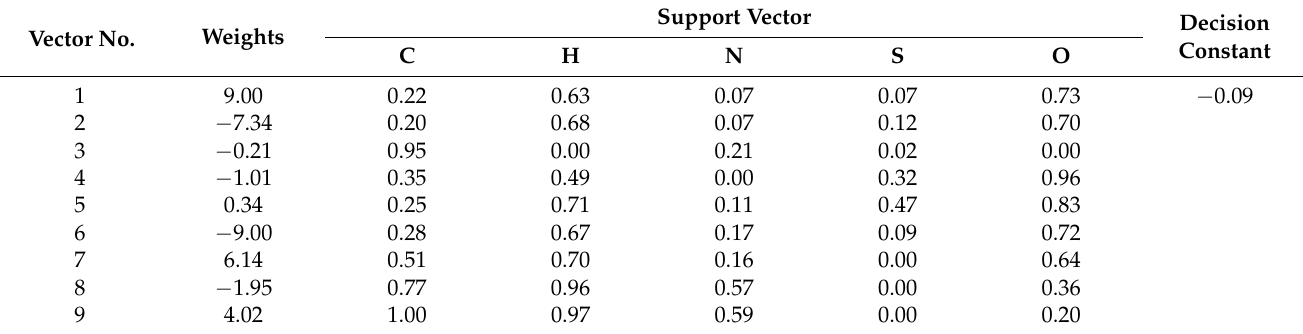
Table 2. Vector values of the developed SVM